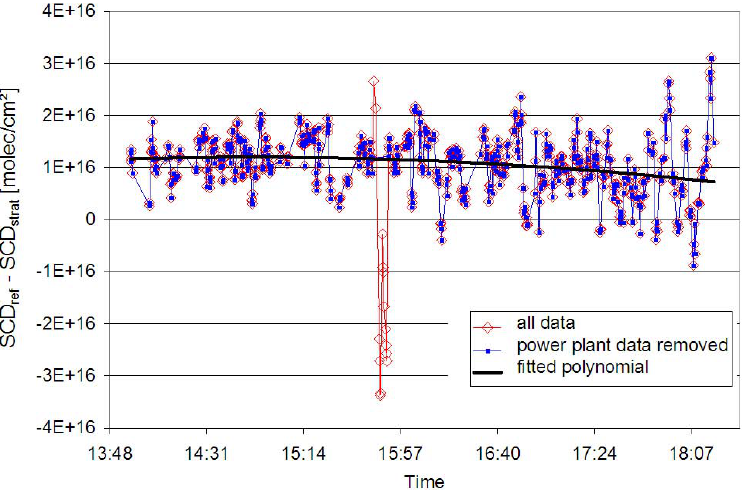
Fig. 3. DSCD offset (see Eq. 15) plotted as a function of time (red points). For the observations close to the power plant, negative outliers are found, which are caused by the sharp gradients of the power plant plume (see text). For the fitting of a low order polynomial (black curve) representing DSCD offset (t i ) (see text), these data were excluded and only the blue points were